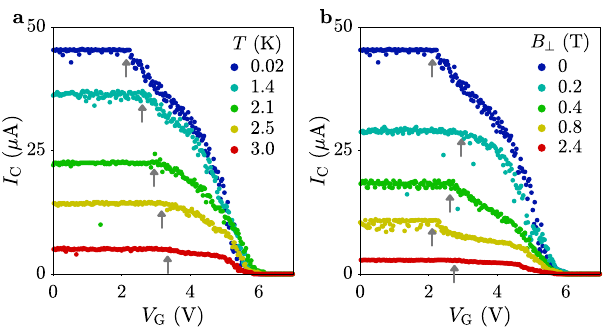
Fig. 2 Temperature and magnetic fi eld dependence. a Critical current I C of the device presented in Fig. 1 as a function of gate voltage V G for various temperatures T (see legend). b Critical current I C of the device presented in Fig. 1 as a function of out-of-plane magnetic fi elds B ⊥ (see legend). Gray arrows indicate the gate voltage where I C